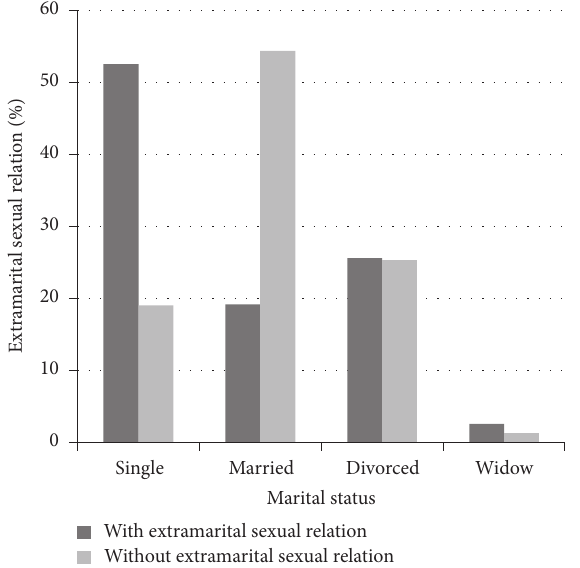
Figure 1: Percentage of extramarital sexual relations in all substance dependent women based on marital status.